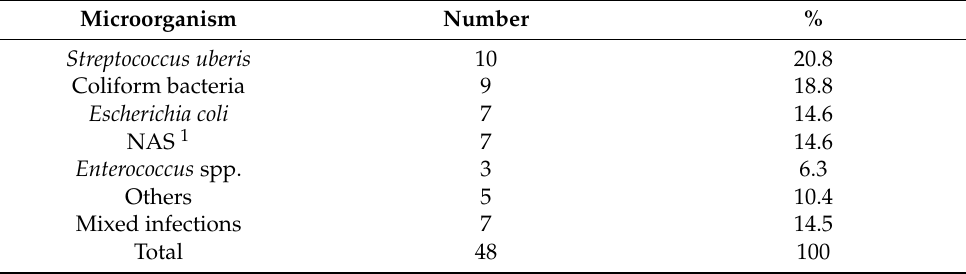
Table 2. Bacteriological culture results of the mastitis milk samples (n =